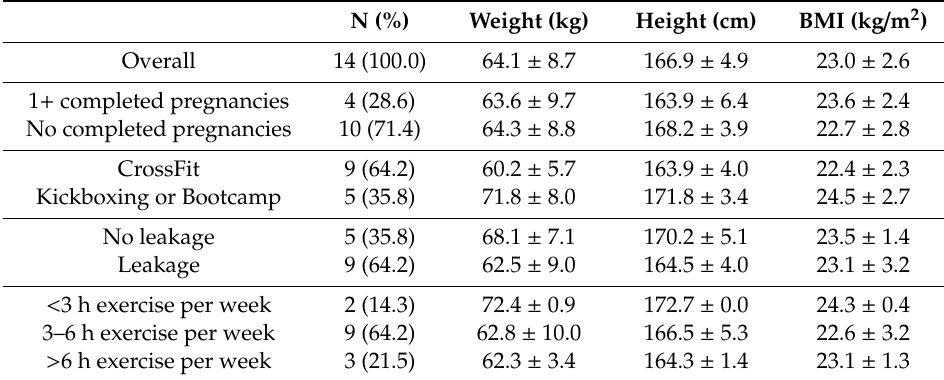
Table 1. Descriptive information on survey